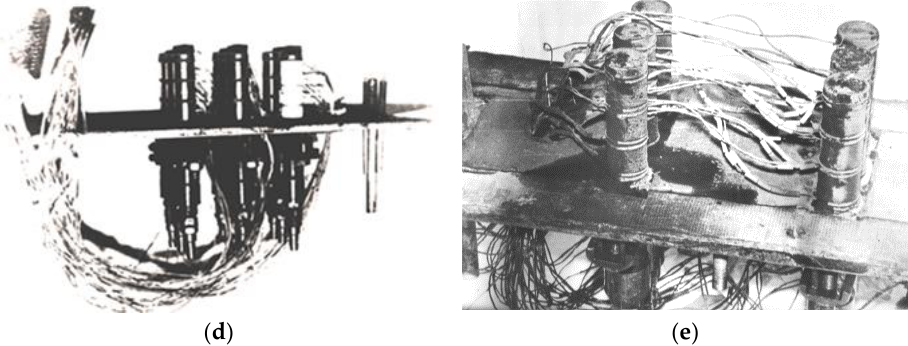
Figure 1. Pictures of the experimental setup ( a ), view of pollutions during WFE ( b ), and fuel oil ( c ) combustion, samples for research of LTC before tests ( d ), and after the tests ( e ).